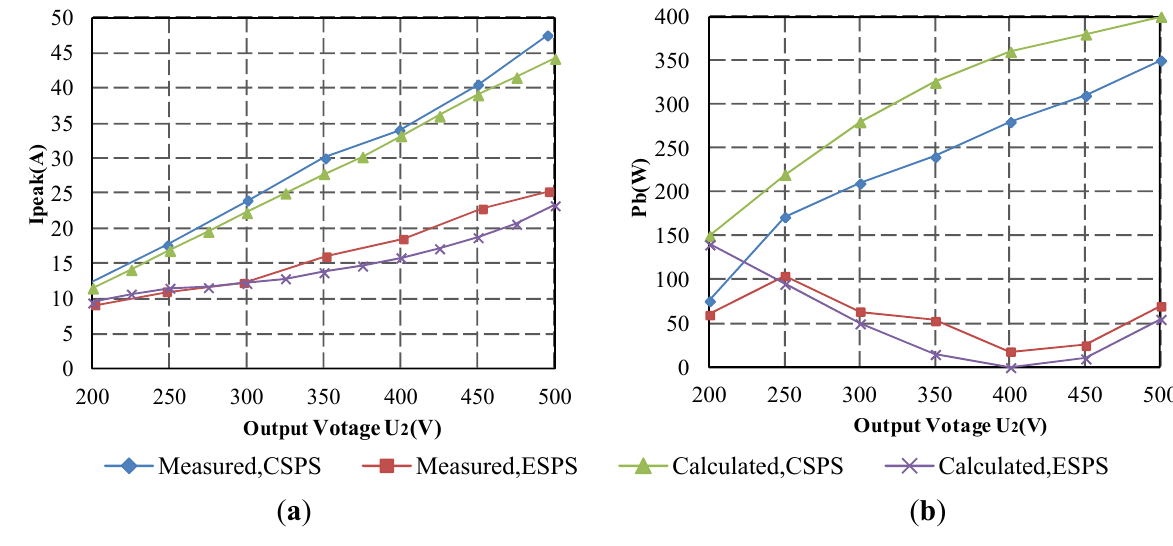
Figure 14. The experimental waveforms of ESPS and CSPS control when output voltages U are 250 V and 500 V. ( a ) ESPS control with U 2 with U = 100 V, U = 250 V; ( c ) ESPS control with U 1 2 control with U = 100 V, U = 500 1 2